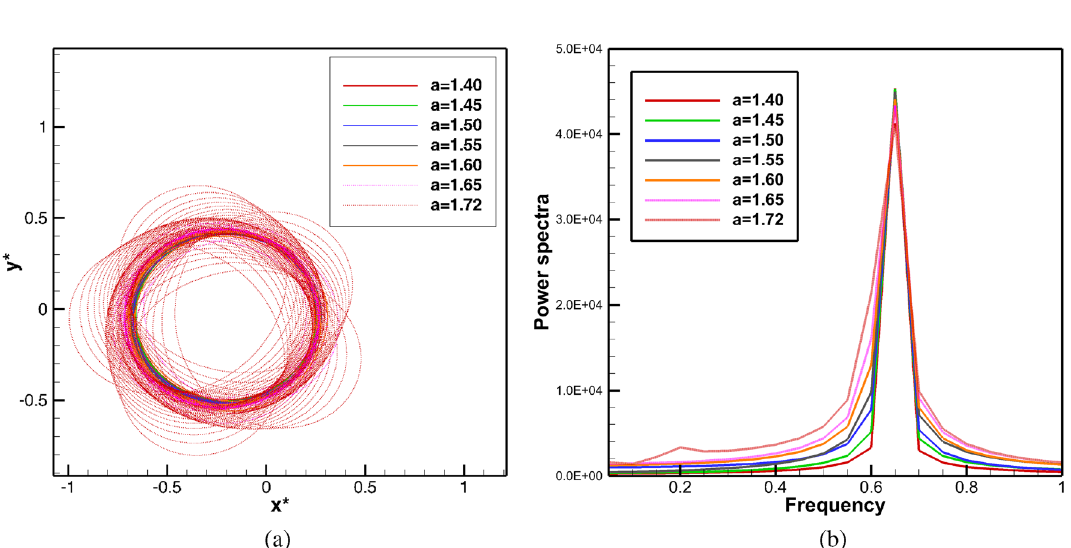
Figure 2. ( a ) Tip trajectories and ( b ) power spectra of the x -coordinate of the tip trajectories of the spiral waves for 1.40 ≤ a ≤ 1.72 in the time range 10 ≤ t ≤ 100